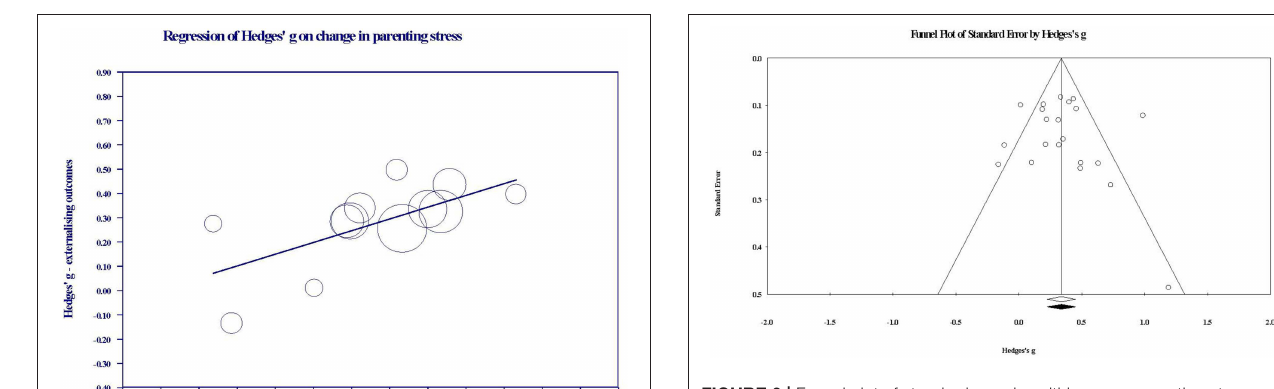
FIGURE 6 | Funnel plot of standard error by within-group parenting stress effect sizes. The white diamond represents the observed summary effect size, while the black diamond represents the imputed summary effect size free of publication bias.